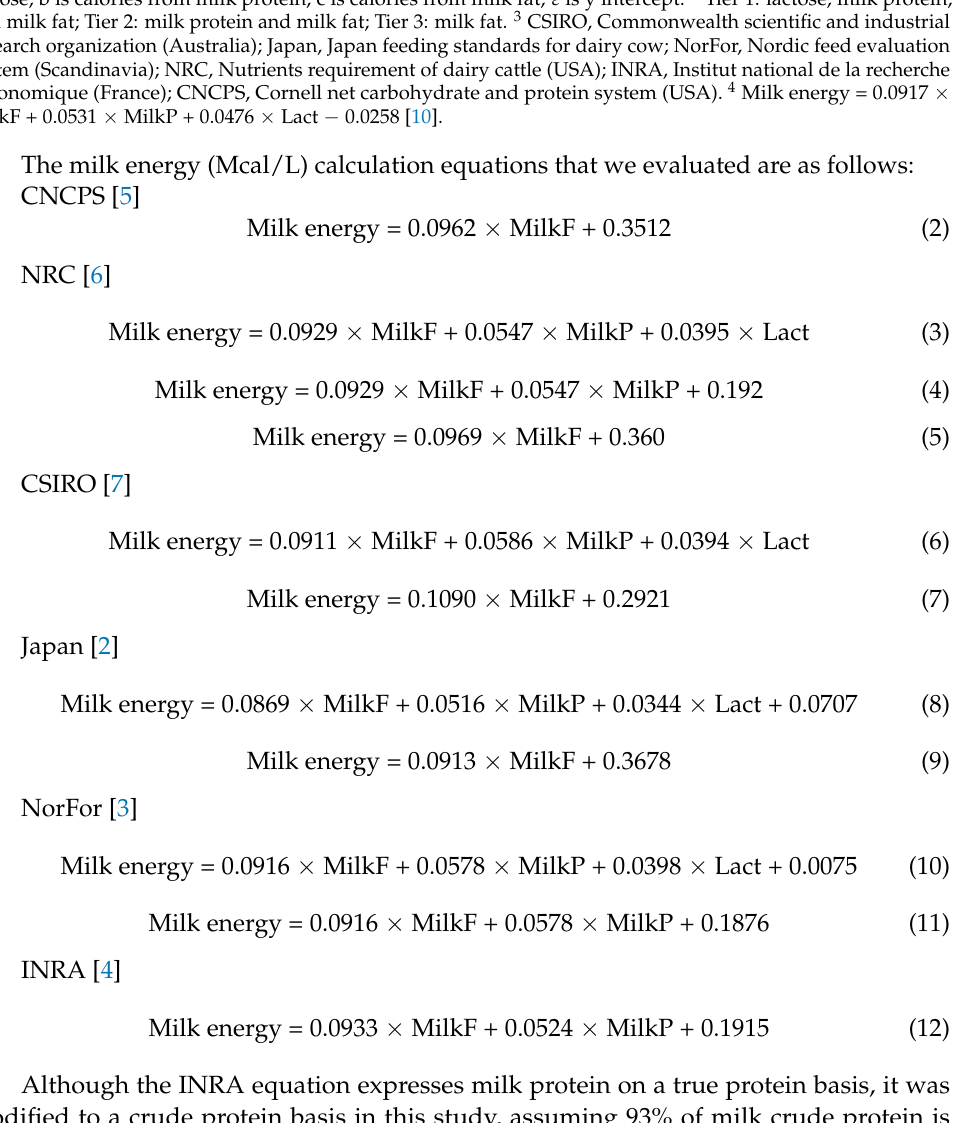
and milk fat; Tier 2: milk protein and milk fat; Tier 3: milk fat. 3 CSIRO, Commonwealth scientific and industrial research organization (Australia); Japan, Japan feeding standards for dairy cow; NorFor, Nordic feed evaluation system (Scandinavia); NRC, Nutrients requirement of dairy cattle (USA); INRA, Institut national de la recherche agronomique (France); CNCPS, Cornell net carbohydrate and protein system (USA). 4 Milk energy =